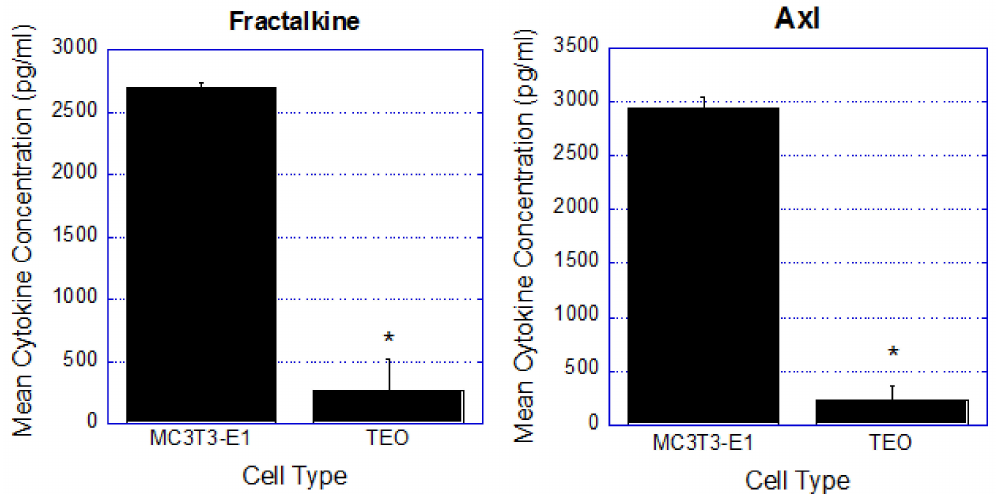
Figure 4. Tumor-educated osteoblast cells have altered cytokine production when compared to untreated osteoblasts. Conditioned media was prepared from untreated MC3T3-E1 osteoblasts or TEO cells and subjected to a RayBiotech Quantibody ® Quantitative Multiplex ELISA Array. Three separate batches of conditioned media were assayed per condition. Shown are the mean protein concentration of Fractalkine and Axl produced by either untreated MC3T3-E1 osteoblasts or TEO cells. * p <